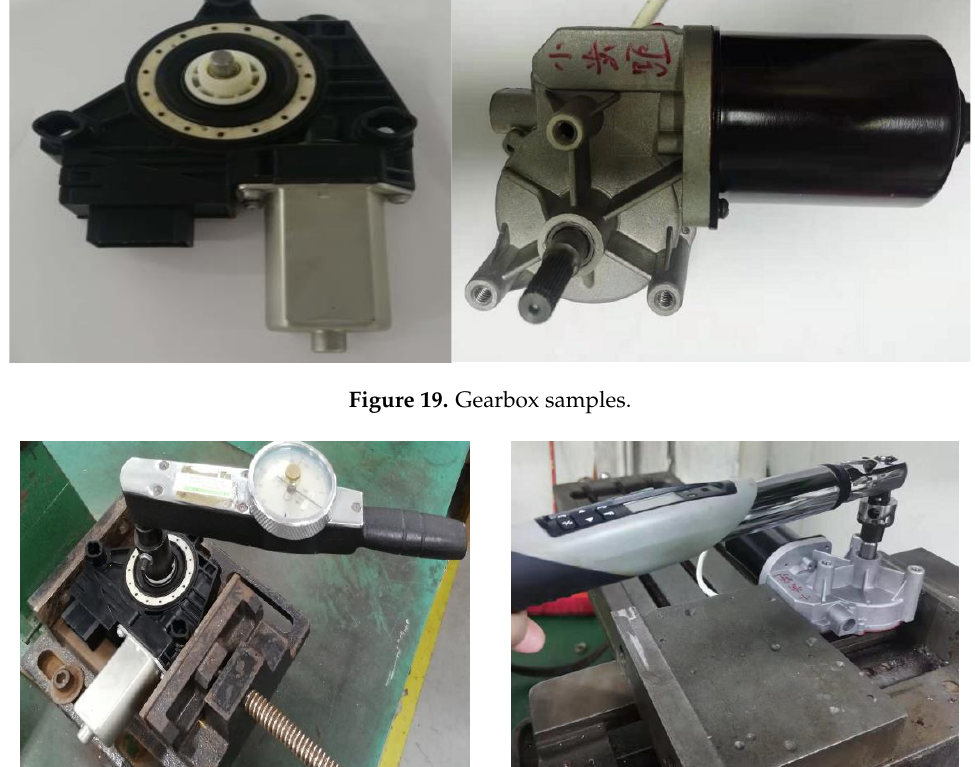
Figure 20. Test on motor (ensure that the worm cannot move). Table 6. Breakage test on the motor.